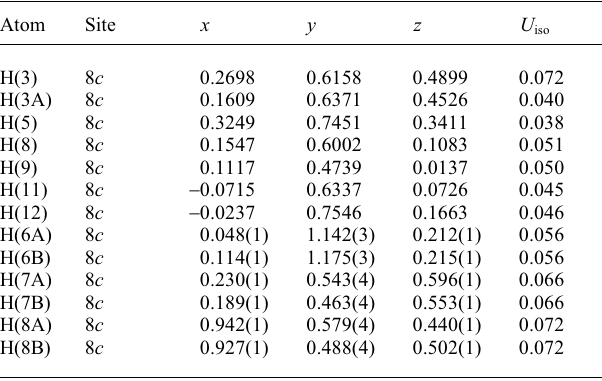
Table 2. Atomic coordinates and displacement parameters (in Å 2 )